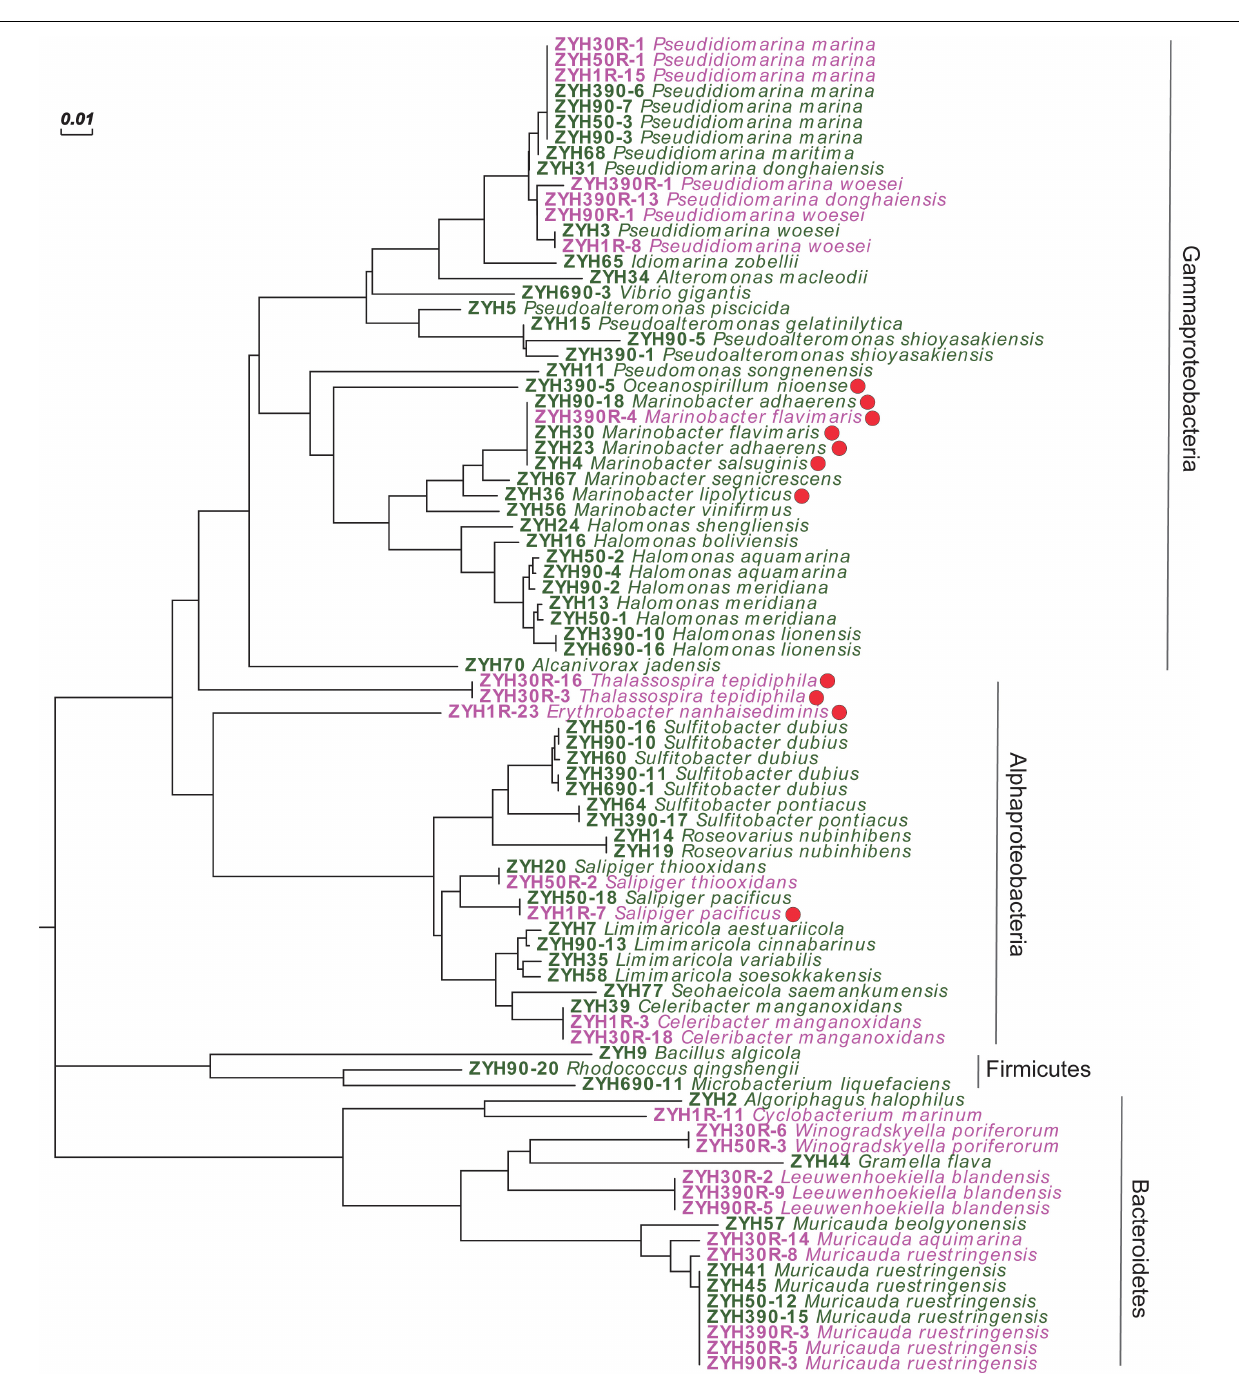
FIGURE 4 | Neighbor-joining tree of 16S rRNA gene sequences of 86 representative cultivated strains. Strains isolated from the natural sediments are labeled in green, and strains isolated from the enriched sediment samples are labeled in pink. Solid red circle represents DMSP-producing isolates. Scale bar represents 0.01 substitutions per nucleotide